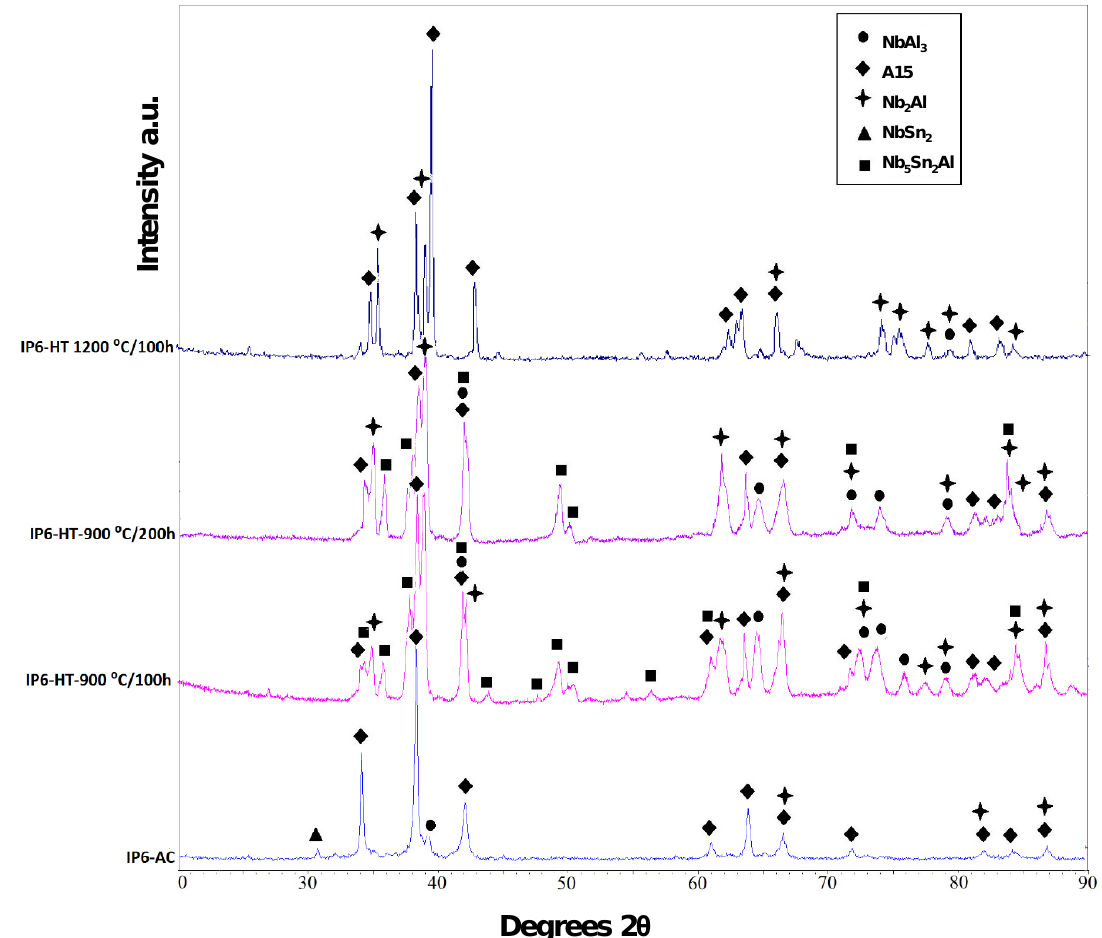
Figure 7. XRD patterns of IP6-AC, IP6-HT-900 °C/100 h, IP6-HT-900 °C/200 h and IP6-HT-1200 °C/100 h.